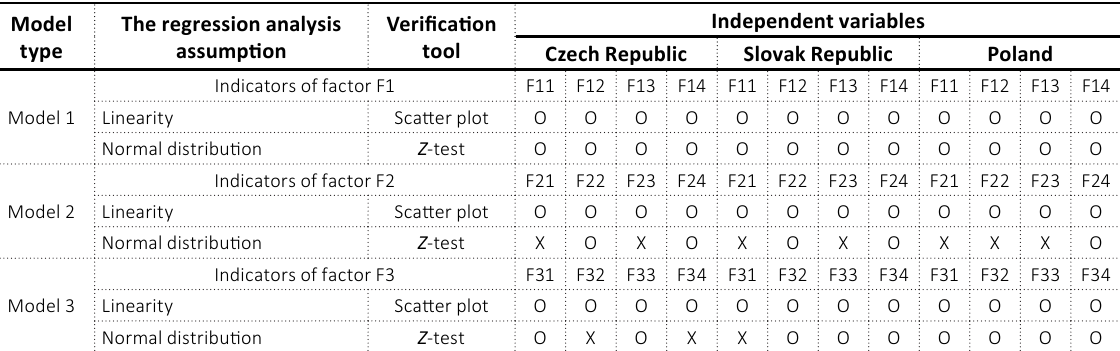
Source: Authors’ results.